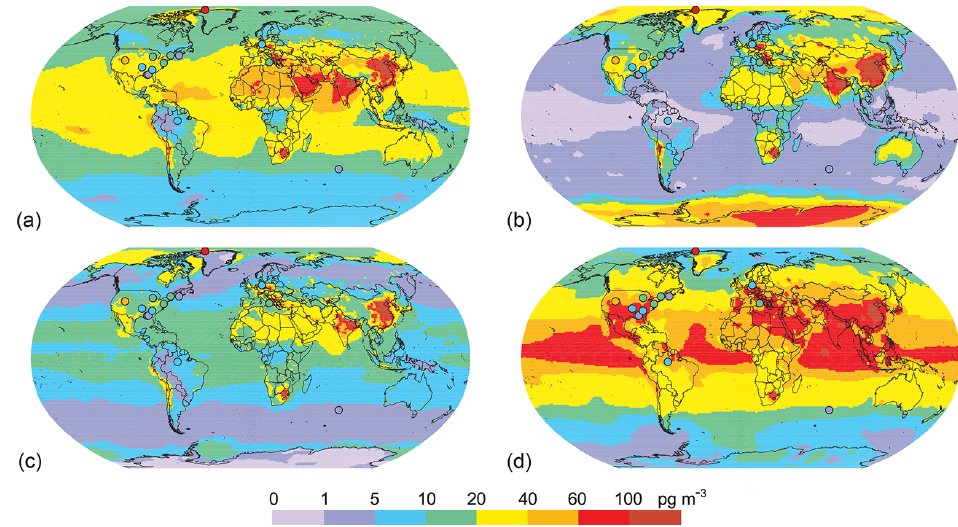
Figure 5. Spatial distribution of annual mean RM air concentration in 2013 simulated according to the BASE case by four global models: (a) GLEMOS, (b) GEOS-Chem, (c) GEM-MACH-Hg, and (d) ECHMERIT. Circles show observed values in the same color scale.